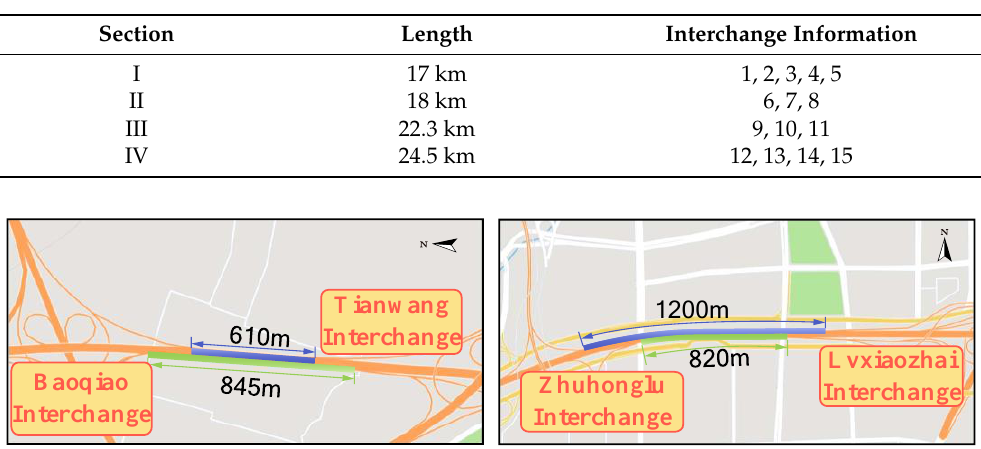
Figure 1. Schematic diagram of G3001 expressway. Table 1. Details of section division.